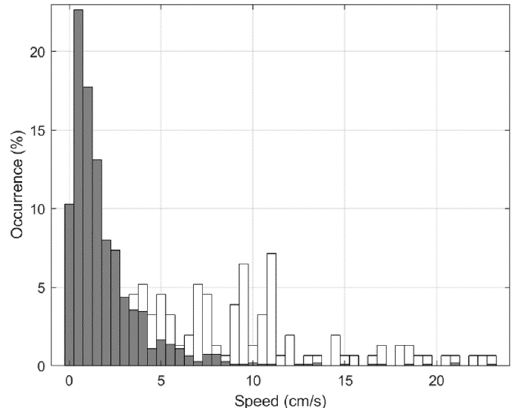
Figure A1. Histogram of the distance between low-pass filtered (hamming 36 h, sampled every 6 h) and interpolated (every 0.5 h) drifter positions, using the entire CALYPSO drifter dataset in the southwestern Mediterranean Sea.